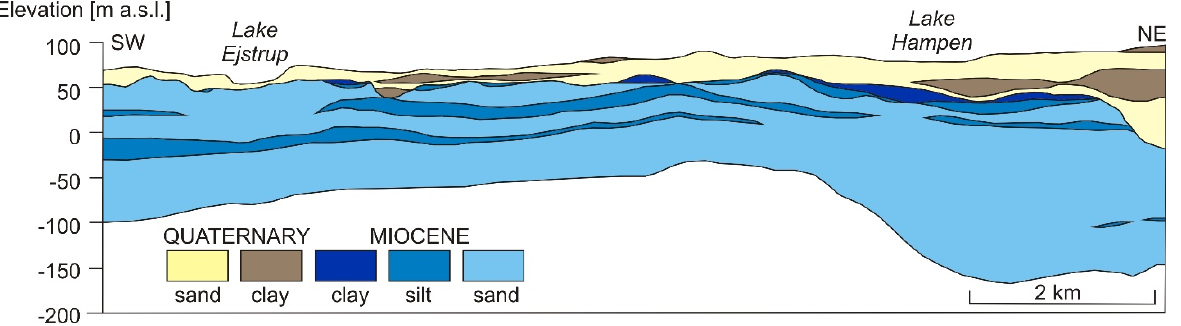
Figure 3. Geological cross-section through the study area (for location see Figure 2). There is a buried valley cutting through Miocene deposits in the NE area of the groundwater catchment. Top elevations of the Miocene formations are at the greater depths east of the main stationary line.